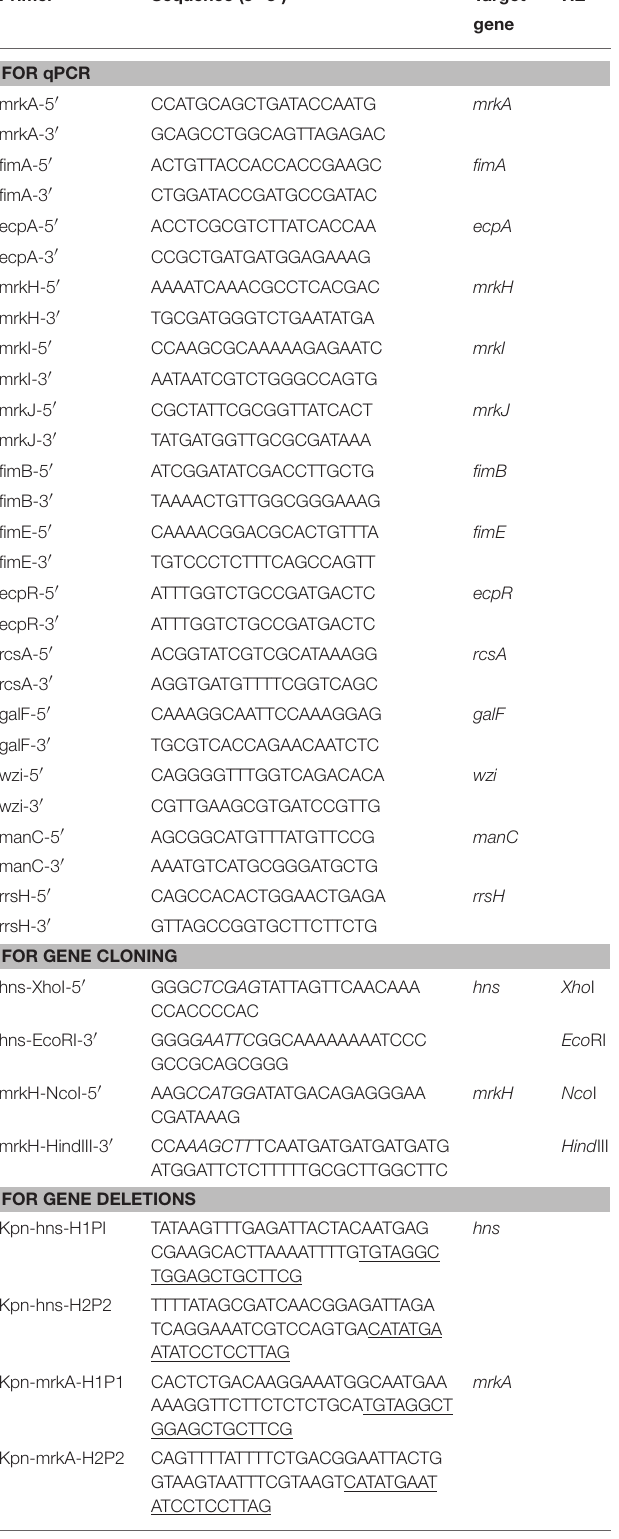
TABLE 2 | Primers used in this